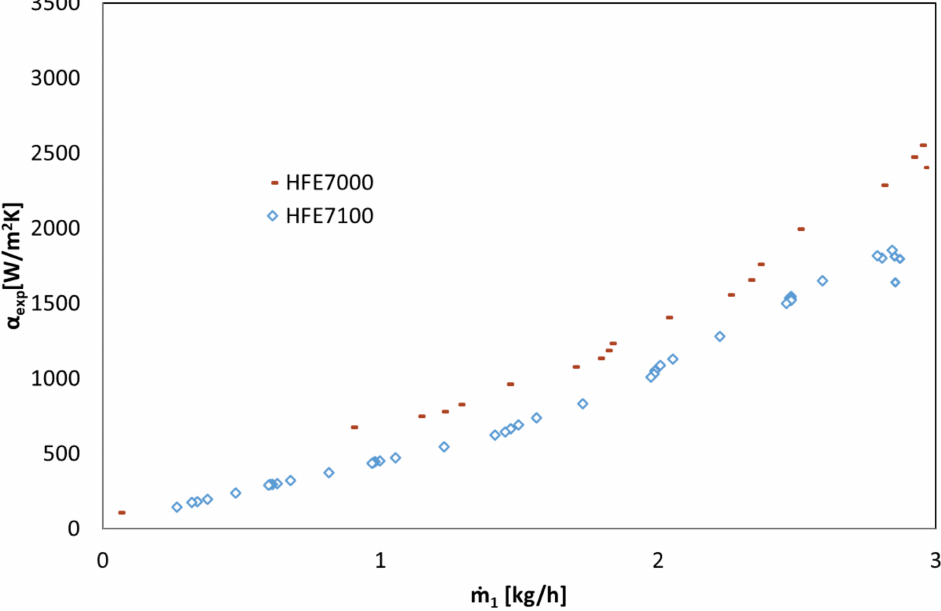
Figure 5. Thermal characteristics of the tested exchanger in the form of the dependence of the heat transfer coefficient on the mass flow rate α = f ( ˙m 1 ), refrigerant HFE 7100, HFE